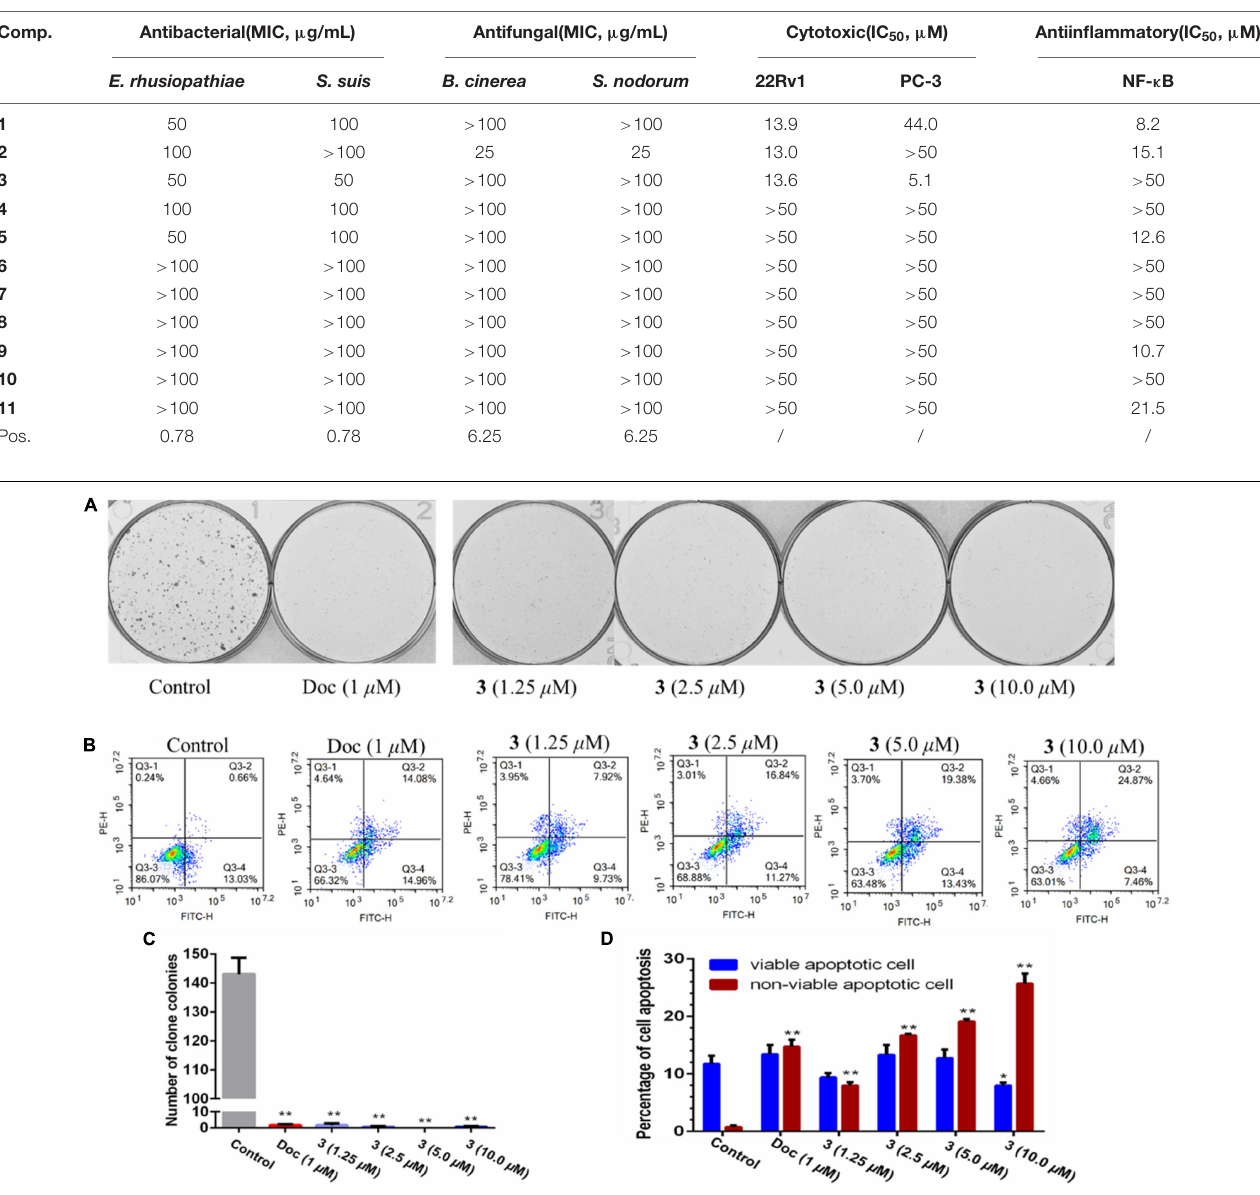
TABLE 4 | Antibacterial, antifungal, cytotoxic, and anti-inflammatory activities of the obtained compounds. Comp.